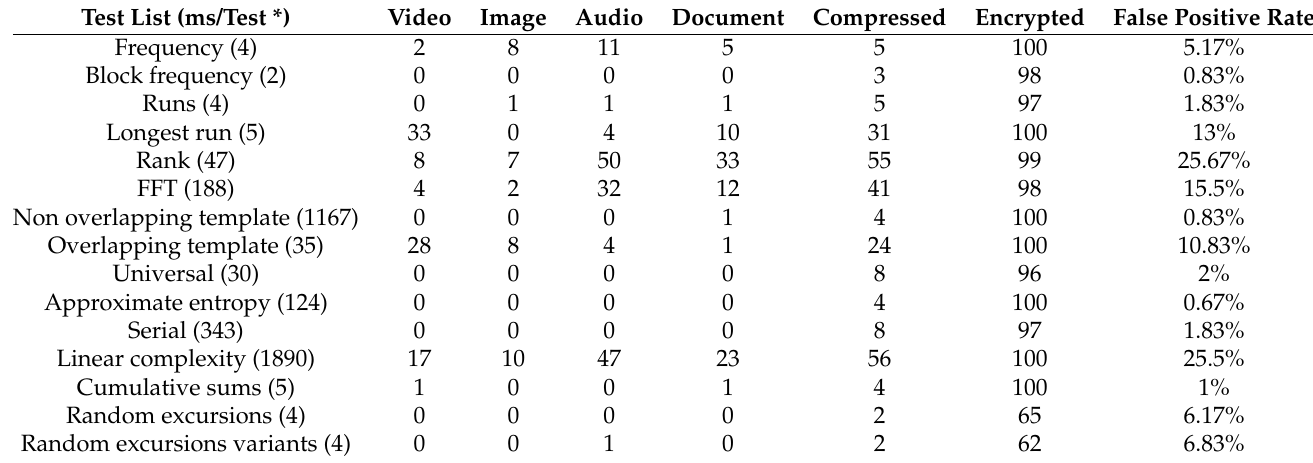
Table 2. Results of statistical randomness tests on our test